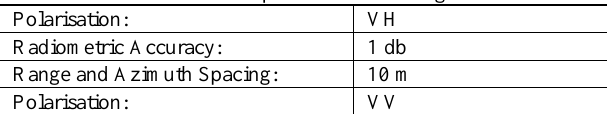
Table 1. Properties of SAR image